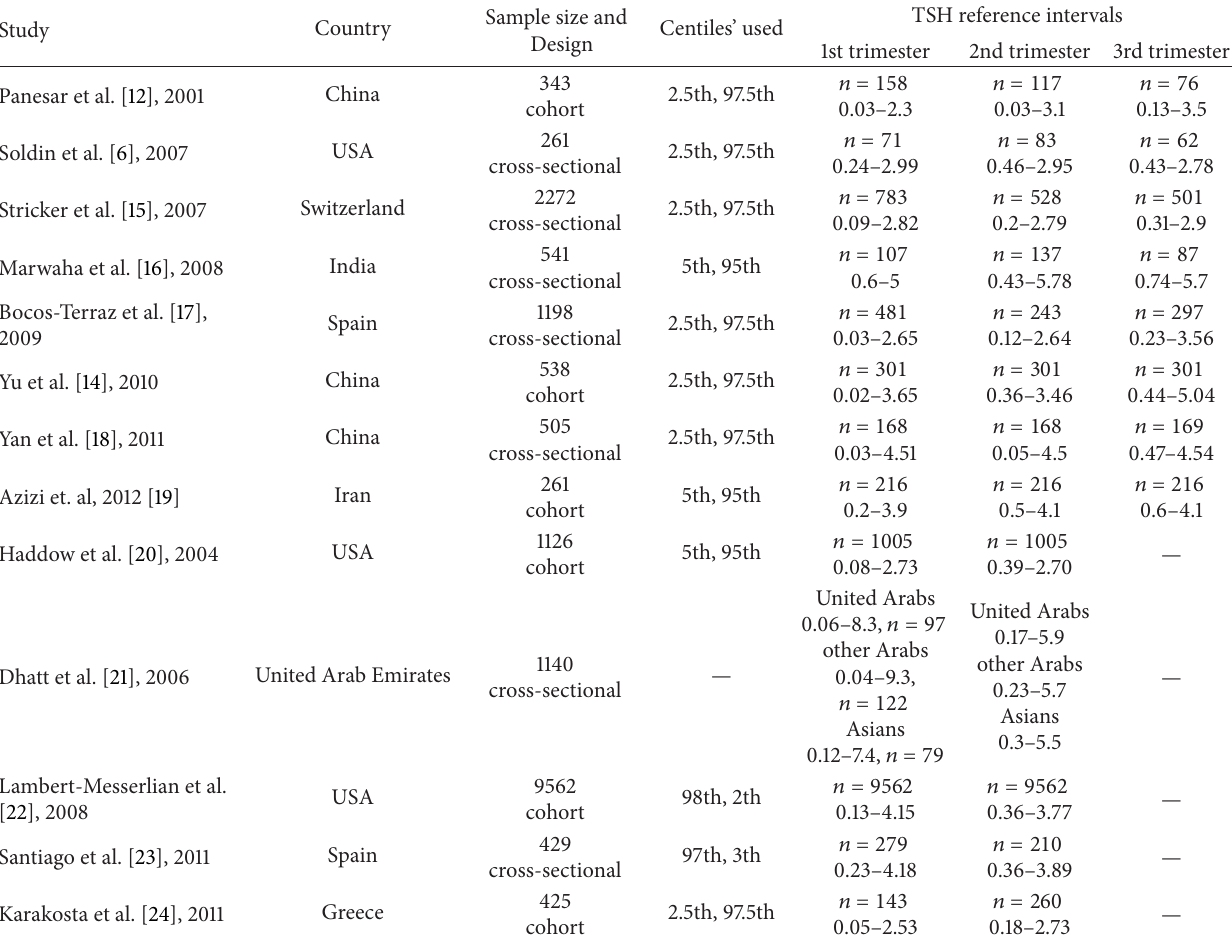
Table 3: Summary of worldwide studies reporting trimester-specific reference intervals for TSH during